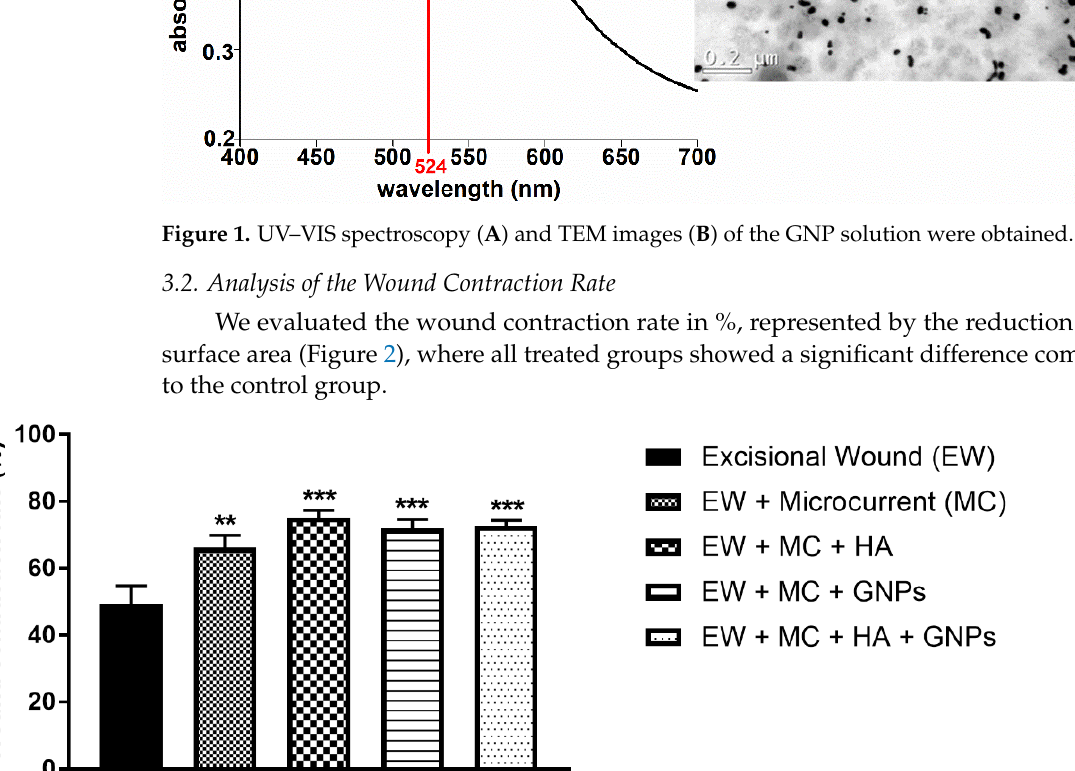
Figure 2. Effects of treatment with MC, GNPs, and hyaluronic acid on wound contraction. The data are presented in mean ± EPM, in which ** p < 0.01 vs. excisional wound group (EW) and *** p < 0.001 vs. excisional wound group (EW); (one-way ANOVA followed by Tukey’s post hoc test).